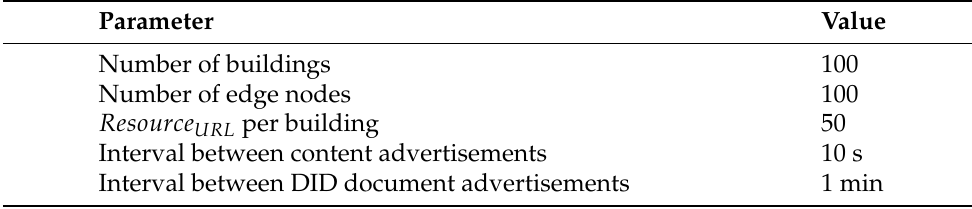
Table 1. Evaluation scenario parameters.